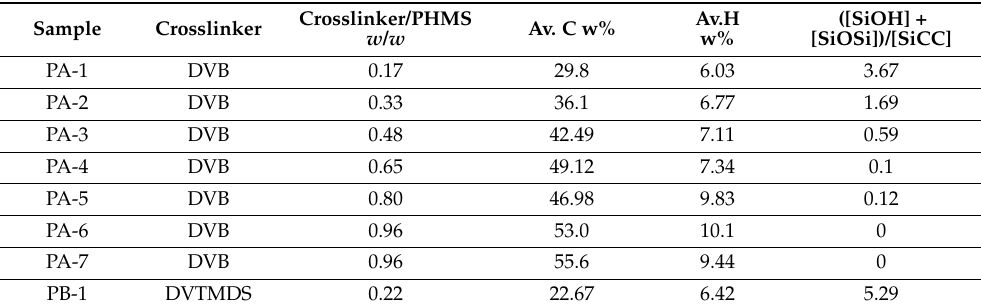
Table 1. Carbon and hydrogen content and the ratio of ([SiOH] + [SiOSi])/[SiCC] in the precursor polysiloxane microspheres.